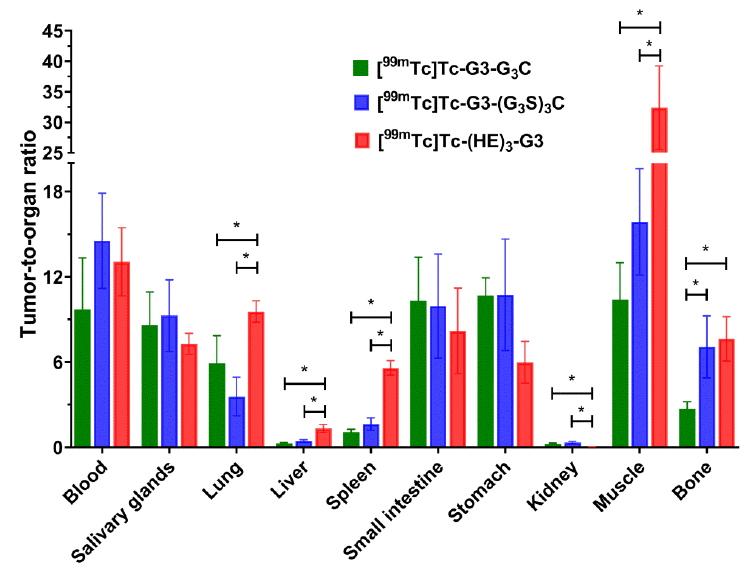
Figure 10. Tumor-to-organ ratios of [ 99m Tc]Tc-G3-G 3 C, [ 99m Tc]Tc-G3-(G 3 S) 3 C, and [ 99m Tc]Tc-(HE) 3 -G3 4 h post-injection (p.i.) in Nu/j mice bearing HER2-expressing SKOV-3 xenografts. Data are presented as mean %ID/g ± SD for four mice. Asterisks mark a significant difference ( p < 0.05, one-way ANOVA).